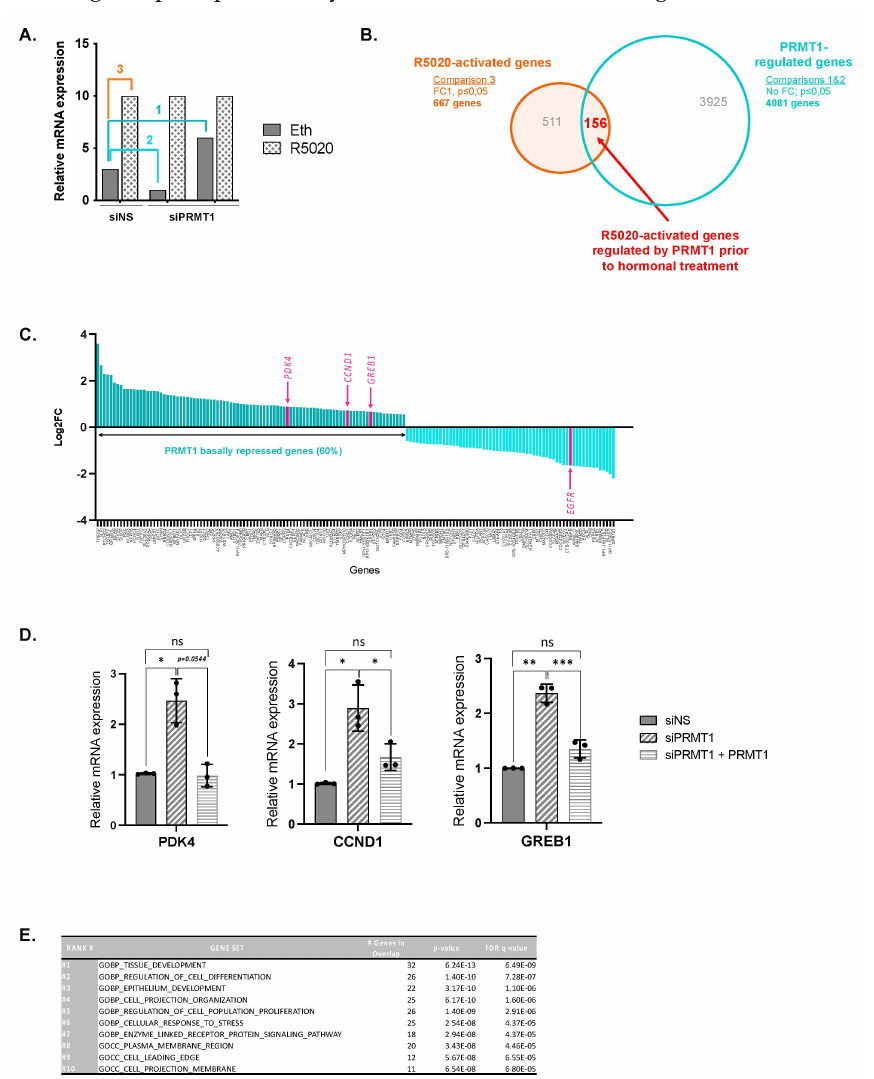
Figure 3. PRMT1 represses the basal expression of an R5020-activated set of genes. ( A – C ) Genome- wide RNA sequencing analysis was performed in T47D cells. From previously published data [8], we analyzed the functional impact of PRMT1 on PR target genes prior to any hormonal stimulation. ( A ) Hypothetical graph illustrating how specific pairwise comparisons were performed between datasets for individual samples. ( B ) The blue Venn diagram represents the PRMT1-regulated (over- expressed and downregulated) genes in unstimulated cells (comparisons 1 and 2, respectively); the orange Venn diagram represents the R5020-regulated genes in cells expressing non-specific control siRNA (siNS) (comparison 3). Overlap area (in red) indicates the number of shared genes among sets. Controls for T47D cell treatments can be found here [8]. ( C ) Representation of fold changes (log2FC) of all target gene expression identified by RNA sequencing analysis (156 genes). On the left (dark